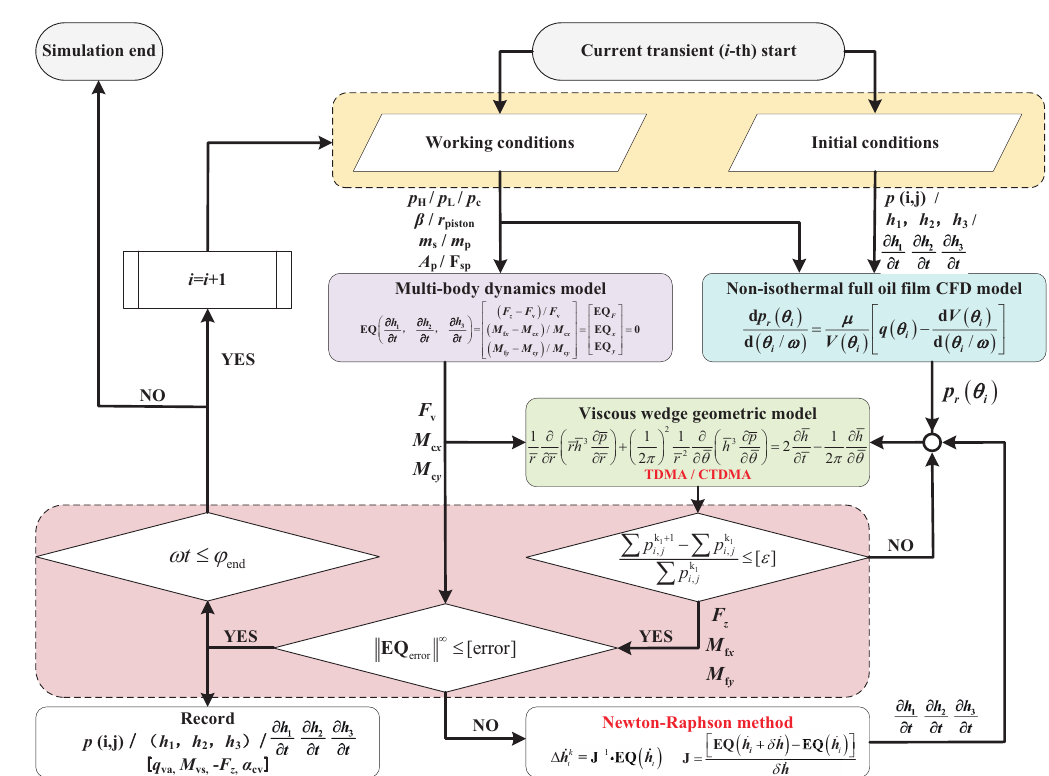
Figure 3. The calculation flow of the oil film model.